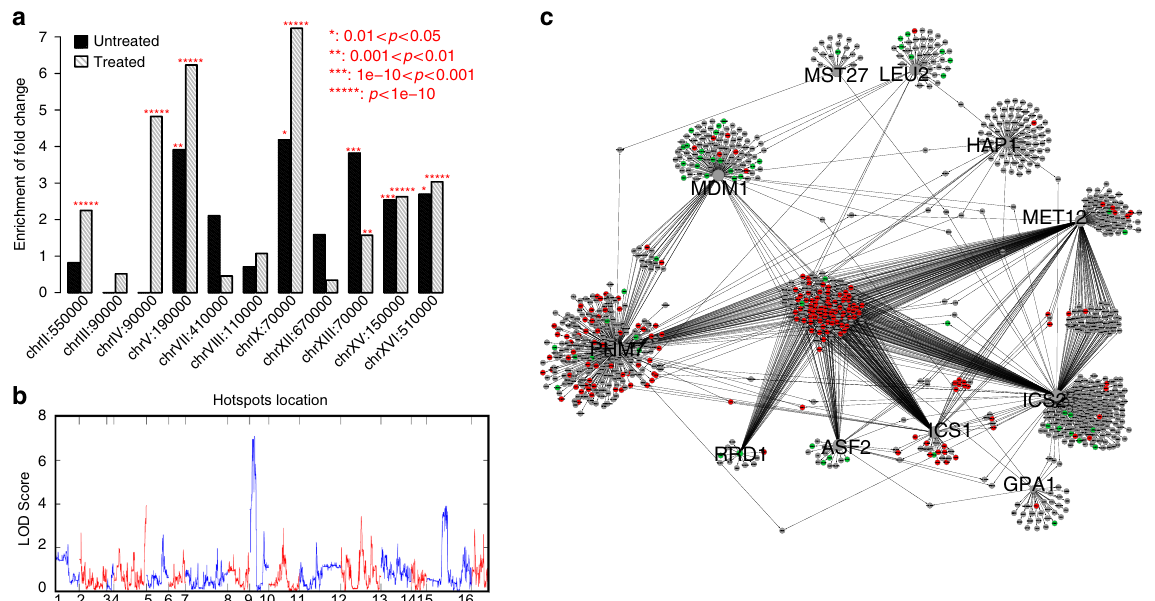
Fig. 5 RRD1 is a putative key causal regulator for the teQTL hotspot chrIX:70,000. a RRD1 ko signatures without and with rapamycin treatment were only compared with teQTL hotspots identi fi ed by MPTGA. RRD1 ko signature with rapamycin treatment ( RRD1 X rapamycin interaction signature) is enriched in multiple teQTL hotspots including ones at chrIX:70,000 and chrXV:170,000. b The teQTL plot for RRD1 based on MPTGA. RRD1 physically locates at chrIX:70,000 and has a strong cis-eQTL at the locus and a trans-eQTL at chrXV:150,000. c The causal network based on TGCT indicates that genes linked to the teQTL hotspot chrIX:70,000 are also regulated by multiple genetic perturbations so that RRD1 ko signature with rapamycin treatment overlaps with multiple teQTL hotspots. Nodes of larger size are putative key causal genes for teQTL hotspots. Red and green nodes represent upregulated and downregulated genes in RRD1 ko, in comparison to wild-type strain when treated with rapamycin,